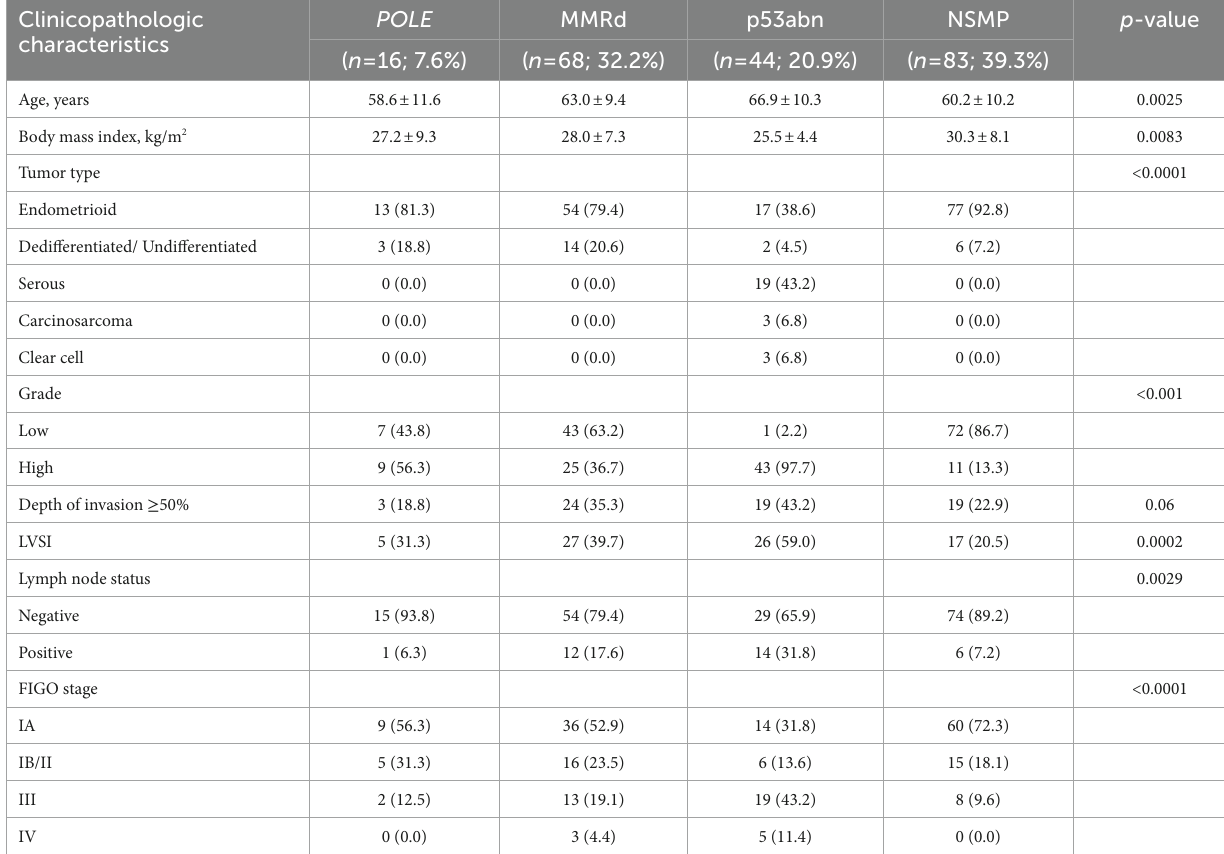
TABLE 2 Clinicopathologic characteristics of molecular subgroups.